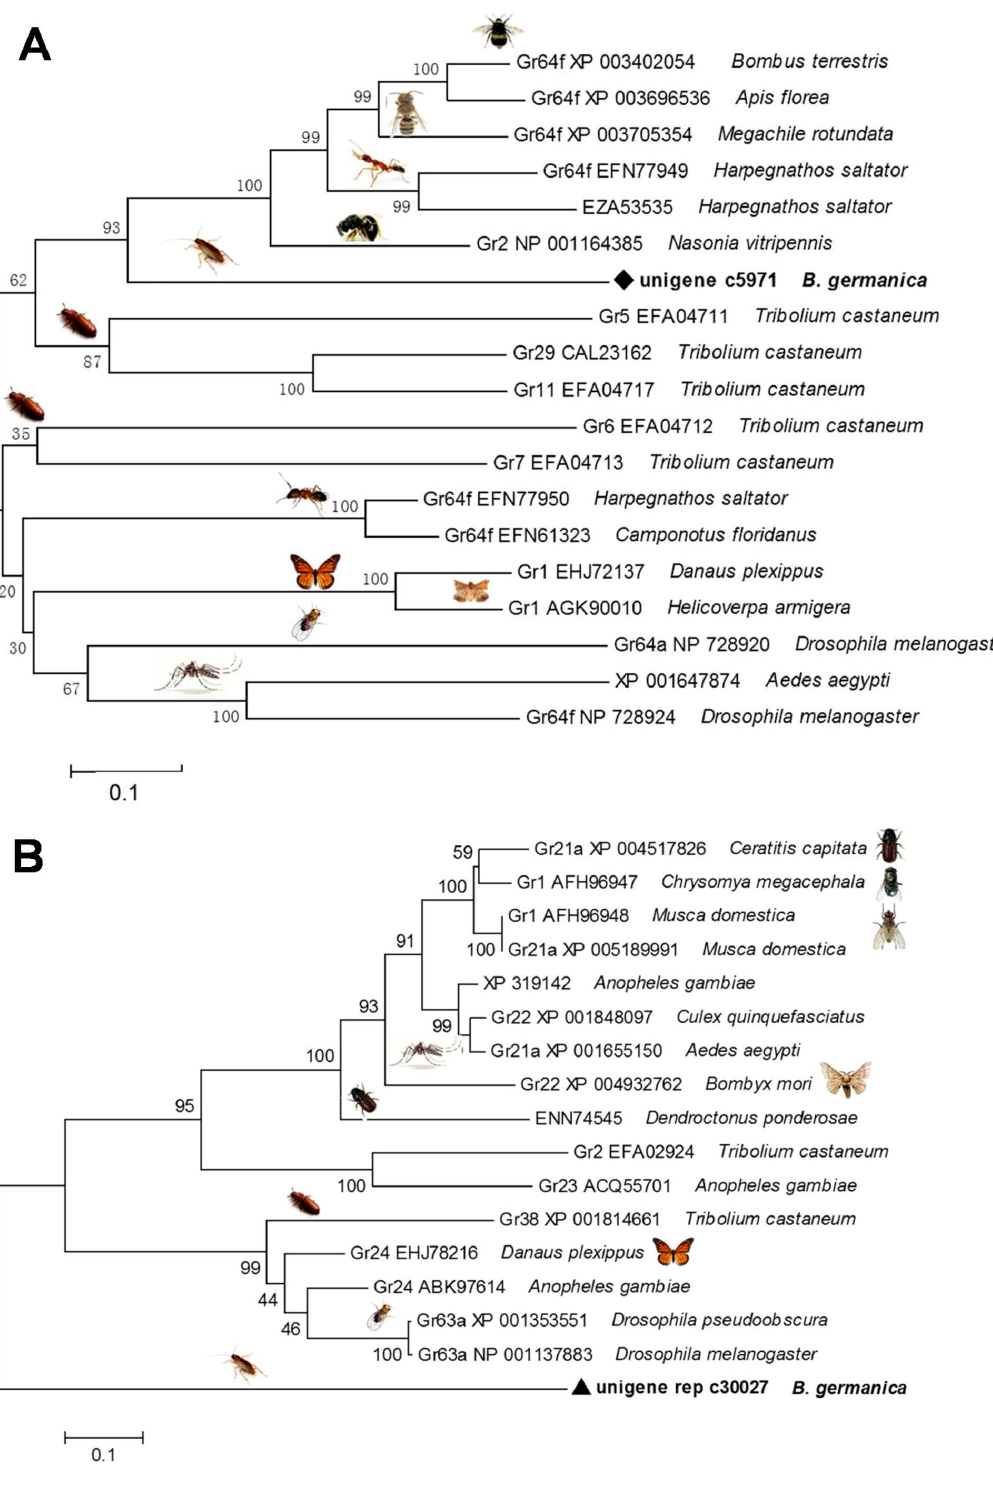
Maderae ) and Sitodiplosis mosellana (orange wheat blossom midge), whereas the Contig 535 was dispersed at the bottom of the tree (Figure 5A). Consistent with their diverse functions, OBPs